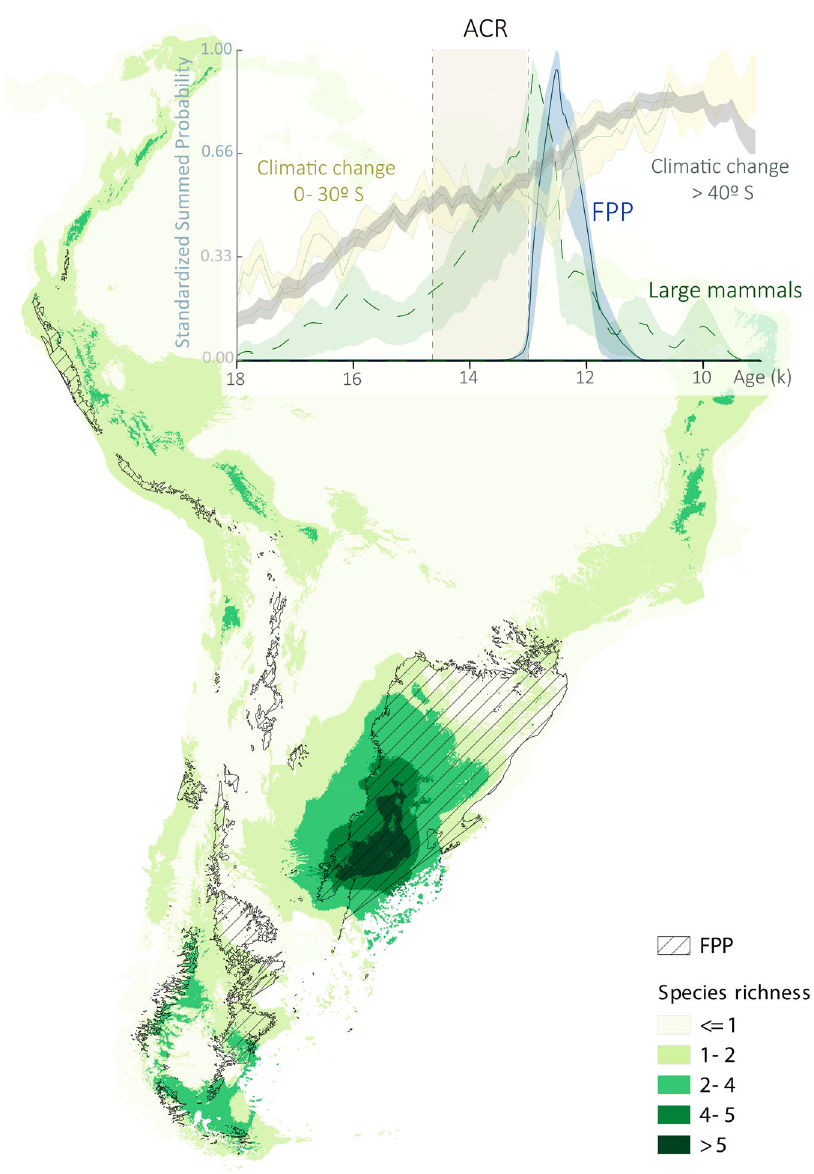
Fig. 8 Summary of spatial (map) and temporal (inset graph) results. Local species richness map of extinct large mammals and the calculated potential distribution of FPP, together with the temporal change in the density of both variables for all of South America and the climatic changes following Pedro et al. 16 . Striped areas in the map represent the potential distribution of FPP. Local species richness of extinct large mammals varies on the map from 1 (light green) to >5 (dark green). Relative climatic changes (temporal temperature curves) are indicated in beige (0 – 30° S) and gray (>40° S), and the ACR period in dark beige. The temporal change in the density of large mammals is represented by light green shading area (lower and upper bounds of the simulated envelope) and dashed green line (observed summed probability). The temporal change in the density of FPP is represented by light-blue shading area (lower and upper bounds of the simulated envelope) and blue line (observed summed probability). In the inset graph X axis represents Calibrated years BP and Y axis the standardized summed